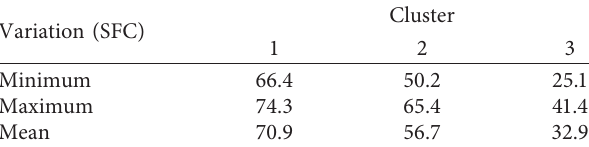
Table 3: K-means clustering center of SFC of concrete pavement.